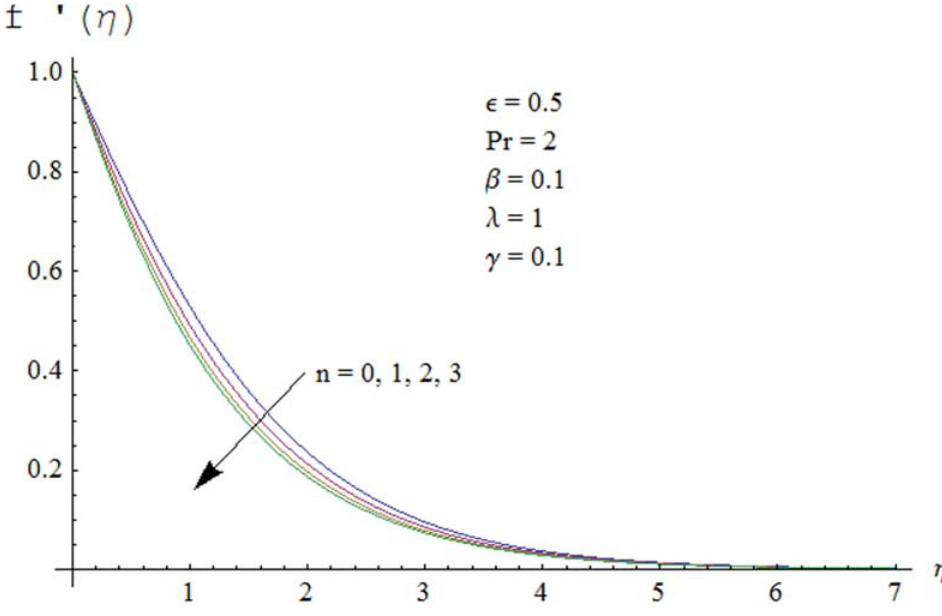
Fig 14. Effect of n on velocity profile.